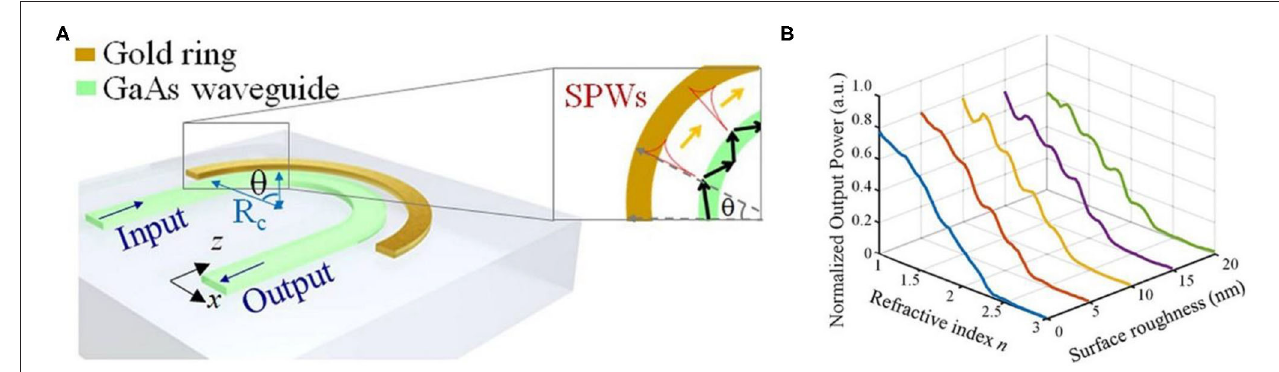
FIGURE 2 | Schematic and performance of a curved-waveguide-based SPP sensor [46]. (A) Schematic of a curved-waveguide-based SPP sensor. The configuration contains a curved GaAs waveguide surrounding by an outer gold ring. The inset picture shows multiple SPW excitations along the surface of the gold ring. (B) The performance of normalized output power vs. refractive index for different surface roughness σ ranging from 0 to 20nm. Reprinted with permission from Cheng et al. [46] © Springer